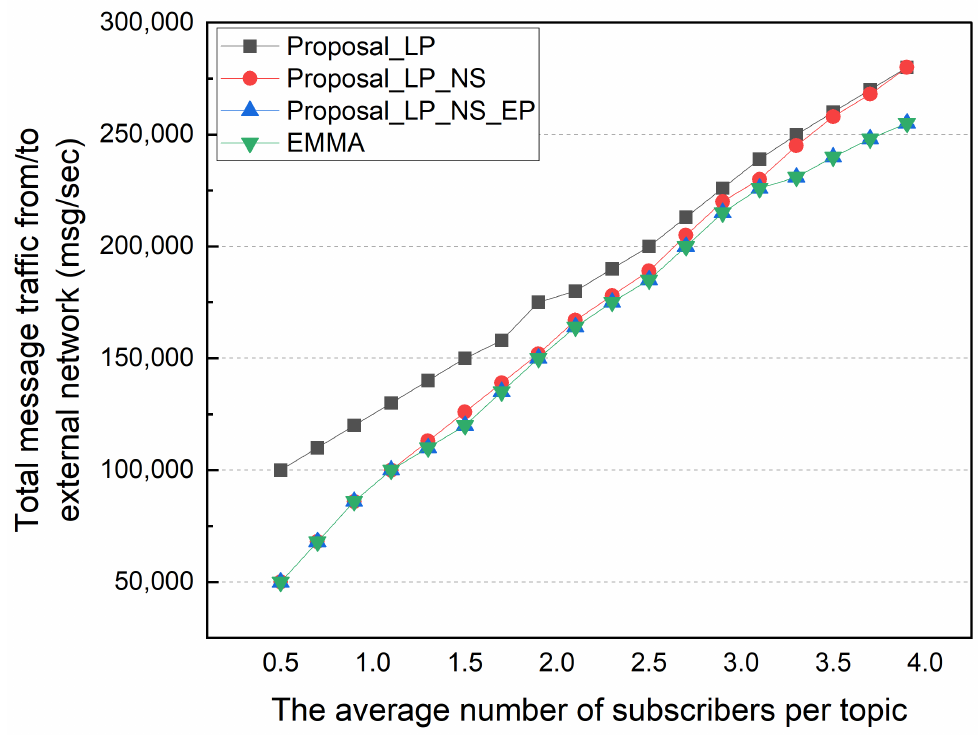
Figure 11. Message traffic between external networks by subscribers per topic.